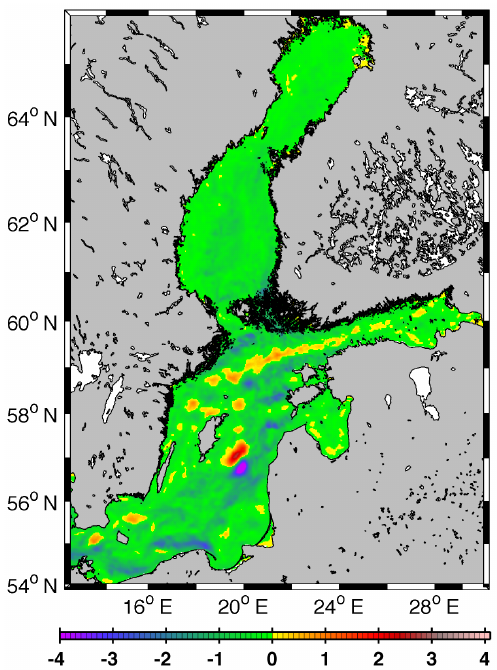
Figure 2. Differences in power driving the oceanic surface circu- lation in units mWm − 2 (calculated as experiment REF – noCW, averaged over the simulated years 1989–1993). Positive (negative) values indicate that more (less) kinetic energy is supplied to the ocean if surface current–wind effects are accounted